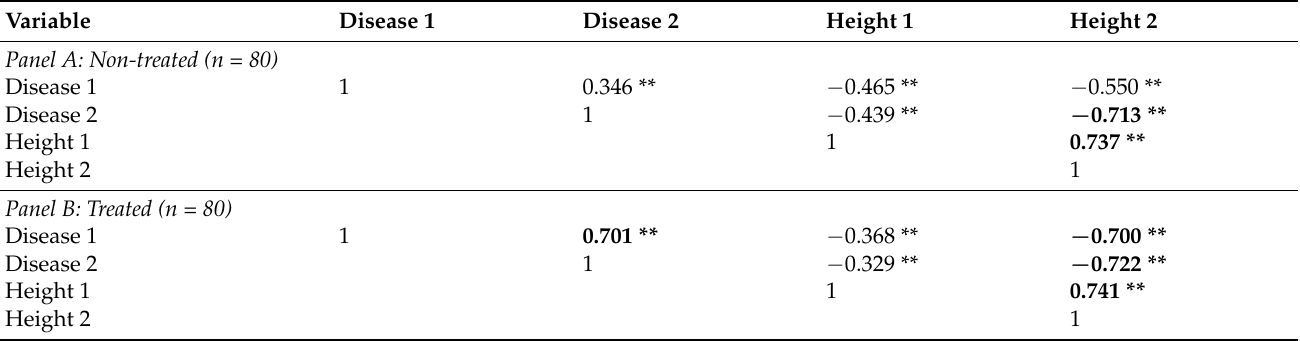
Disease 1: ratio of sporulating damped-off plants and healthy sunflowers nine days after inoculation. Disease 2: ratio of chlorotic damped-off plants and healthy sunflowers 21 days after inoculation. Height 1: height of sunflowers nine days after inoculation (heights of damped-off plants were taken as zero). Height 2: height of sunflowers 21 days after inoculation (heights of damped-off plants were taken as zero). Treatment: